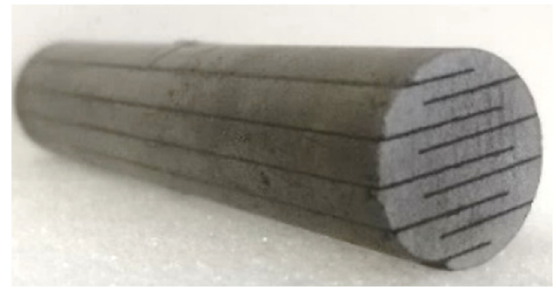
Figure 2. Photo of GMM rod for experiment.